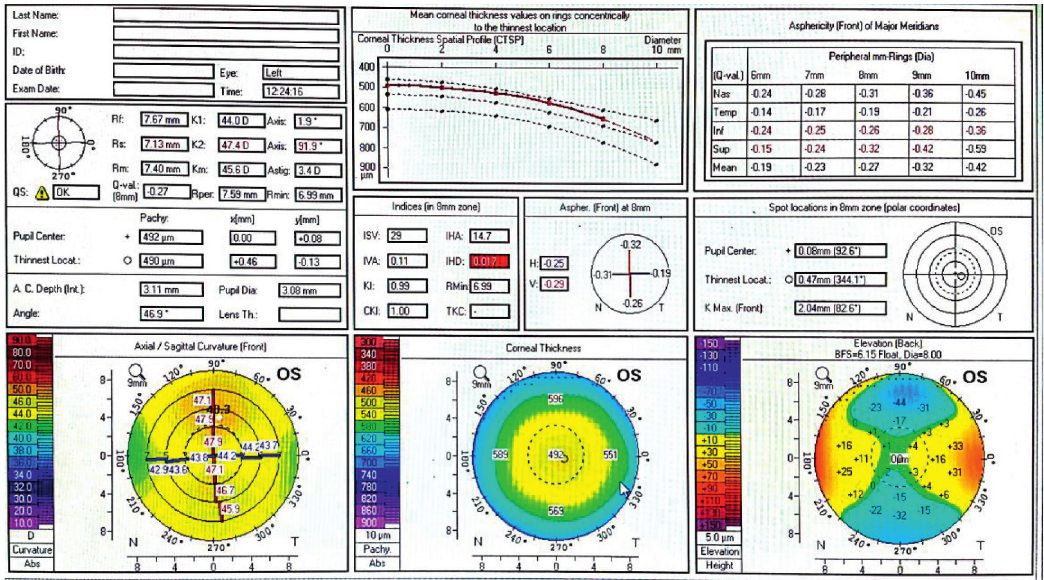
Figure 1: Pentacam of the left eye of a patient in group 1 (normal).